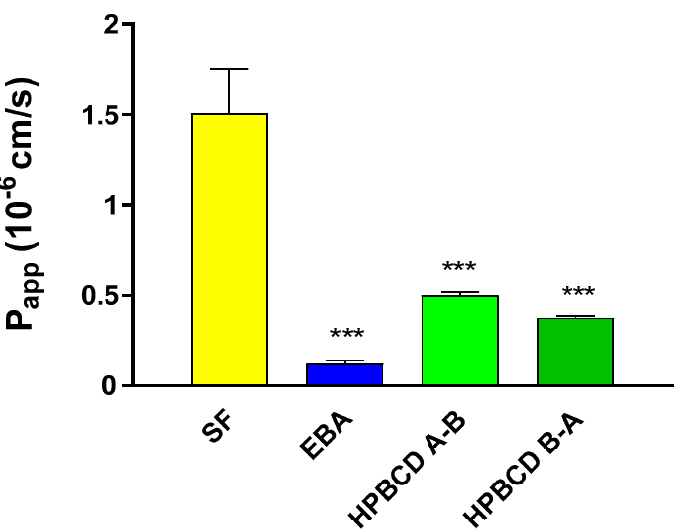
Figure 7. Permeability of FITC-HPBCD (50 µM) and marker molecules (SF, EBA) across the primary- cell-based BBB model. Values presented are means ± SEM. Statistical analysis: one-way analysis of variance followed by Dunnett’s post-test. *** p < 0.001, compared to SF treated group, n = 4. (P app - apparent permeability coefficient).